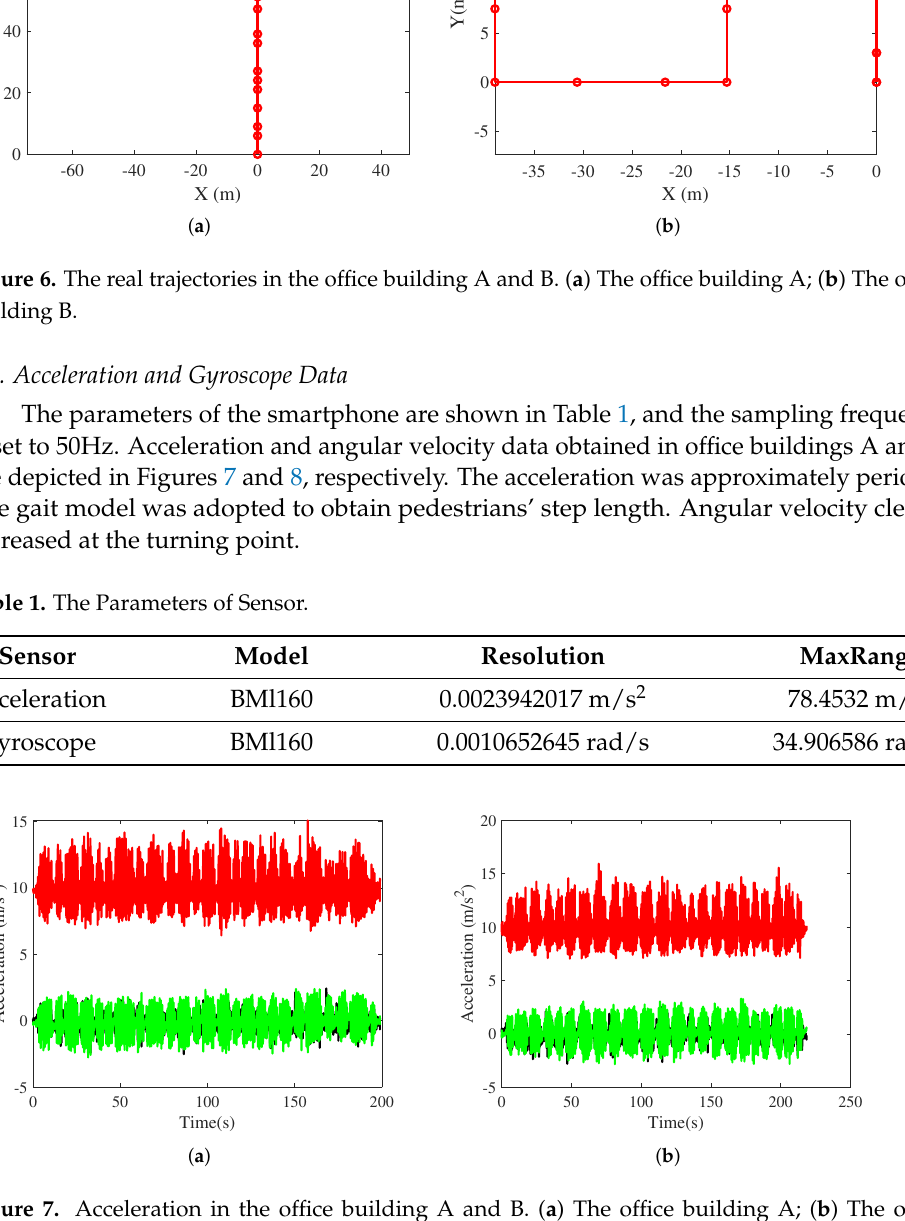
Figure 7. Acceleration in the office building A and B. ( a ) The office building A; ( b ) The office building